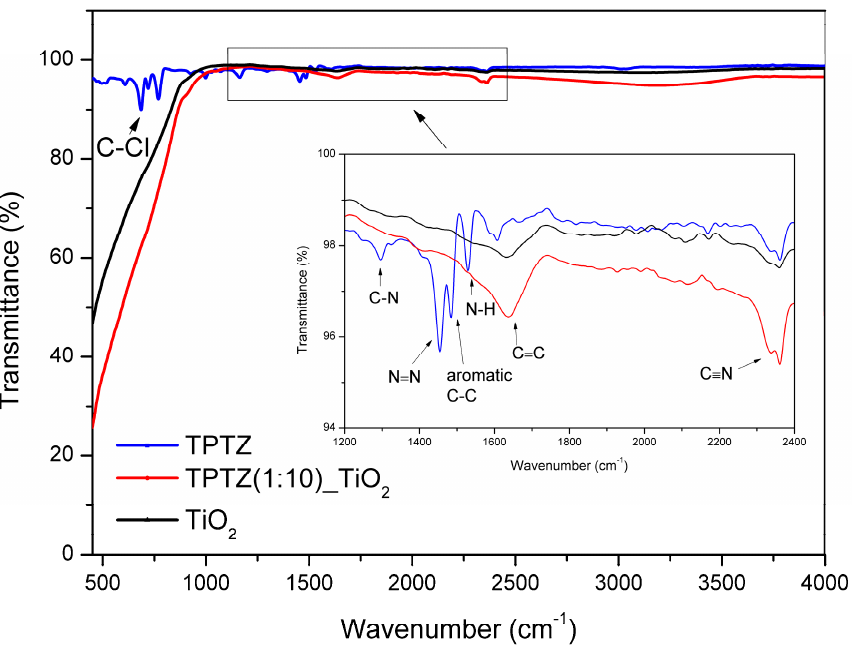
Figure 9. FTIR analysis of pristine IL and TPTZ(1:10)_TiO 2 _24 h sample in comparison with that of pristine TiO 2 .